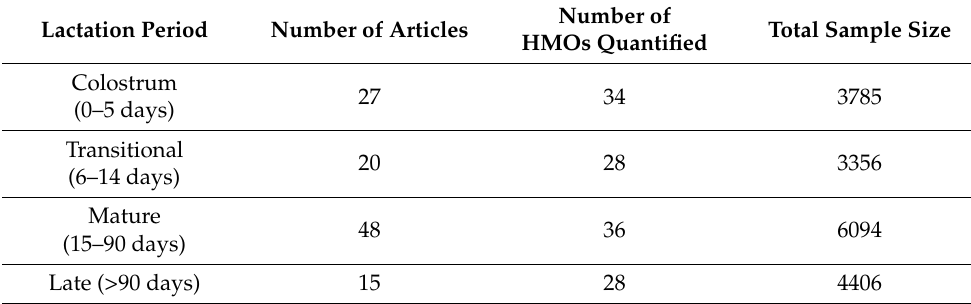
Table 4. Overview of the reported data for individual HMOs per lactation period. Lactation Period Number of Articles Colostrum